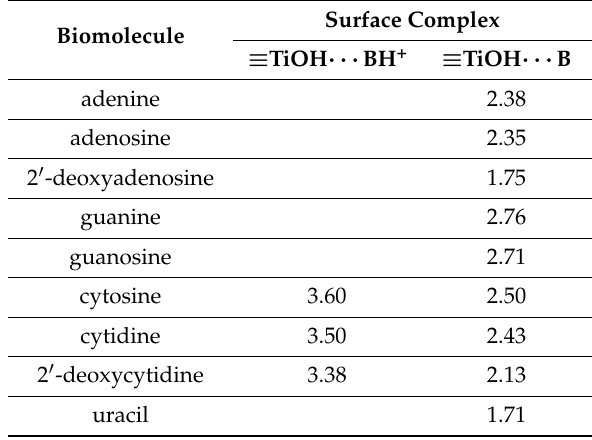
Table 2. Formation constants of nucleobase and nucleoside surface complexes (logK ± 0.05).